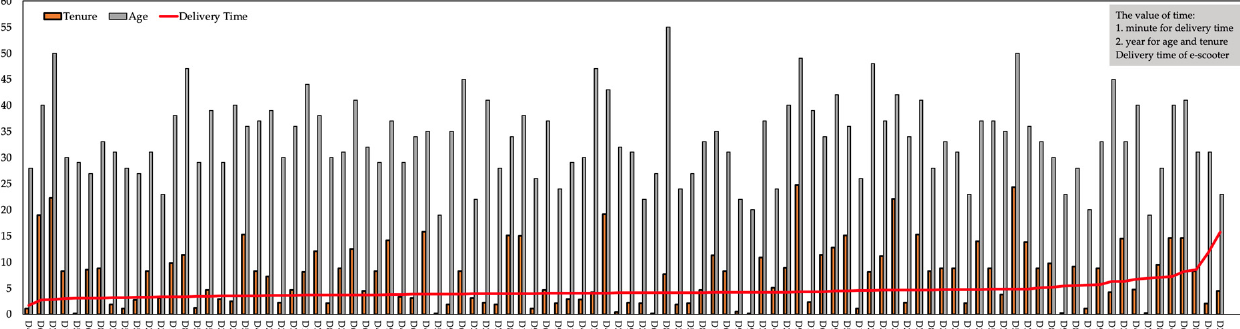
Figure 1. Plot zones selected for packages delivered with the e-scooter application. One hundred e-scooters accompany one hundred drivers (each scooter belongs to only one driver, e-scooter vehicles are not shared between drivers) working in plot areas. The relationship between the age and occupational experience of 100 drivers employed in packages and mail delivery based on the delivery time by e-scooter is shown in Figure 2.